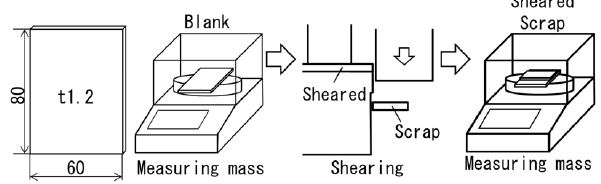
Figure 11. Measuring method of mass of shearing slivers.